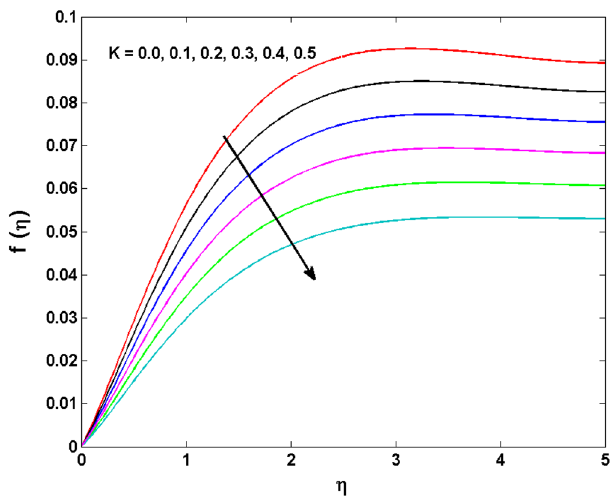
Figure 2. Variations of K to f (η) .